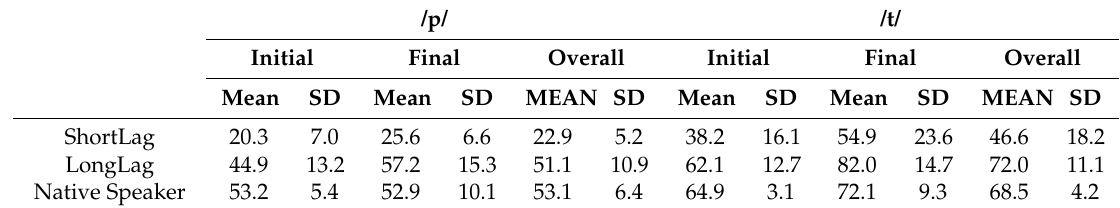
Table 2. Mean Voice Onset Time (VOT) of /p, t/ (in ms) produced by the bilingual speakers and native English speakers in the English-only condition in sentence-initial and sentence-final words. /p/ /t/